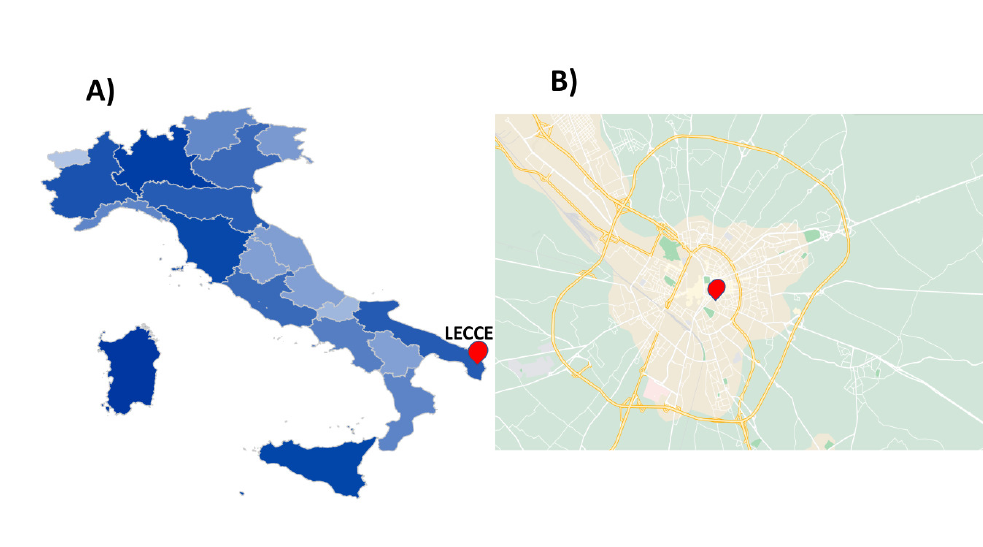
Figure 2. Map of Italy with Lecce location (panel A ); plant of Lecce, the position of monitoring station (panel B